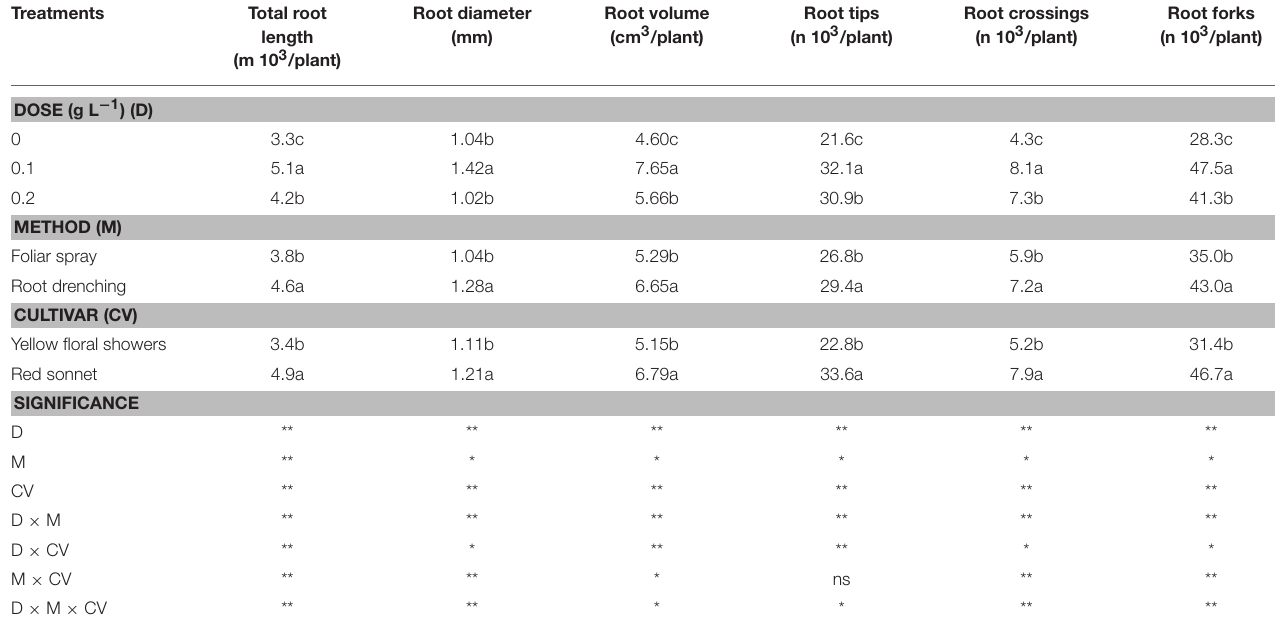
TABLE 4 | Main effects of biostimulant dose, application method and cultivar on total root length, root diameter, root volume, root tips, root crossings, and root forks in snapdragon plants.